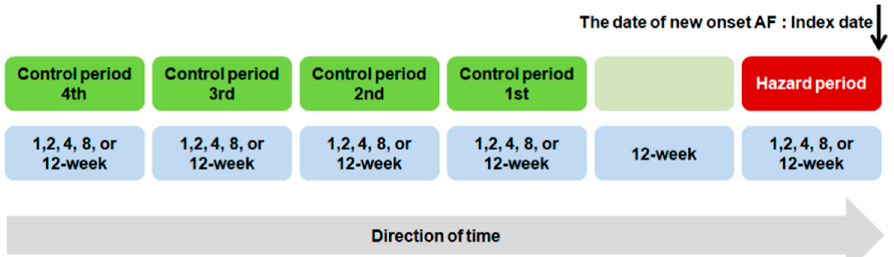
Figure 1. Time sequence of hazard and control periods in this case-crossover study. For each patient with AF, one hazard period and four control periods were paired. Each hazard period was defined as a period of 1, 2, 4, 8, or 12 weeks before the index date. An interval of 12 weeks was selected between the end of the control period and the beginning of the hazard period. For all individual cases, four control periods were also defined as consecutive 1-, 2-, 4-, 8-, and 12-week time windows. AF, atrial fibrillation.